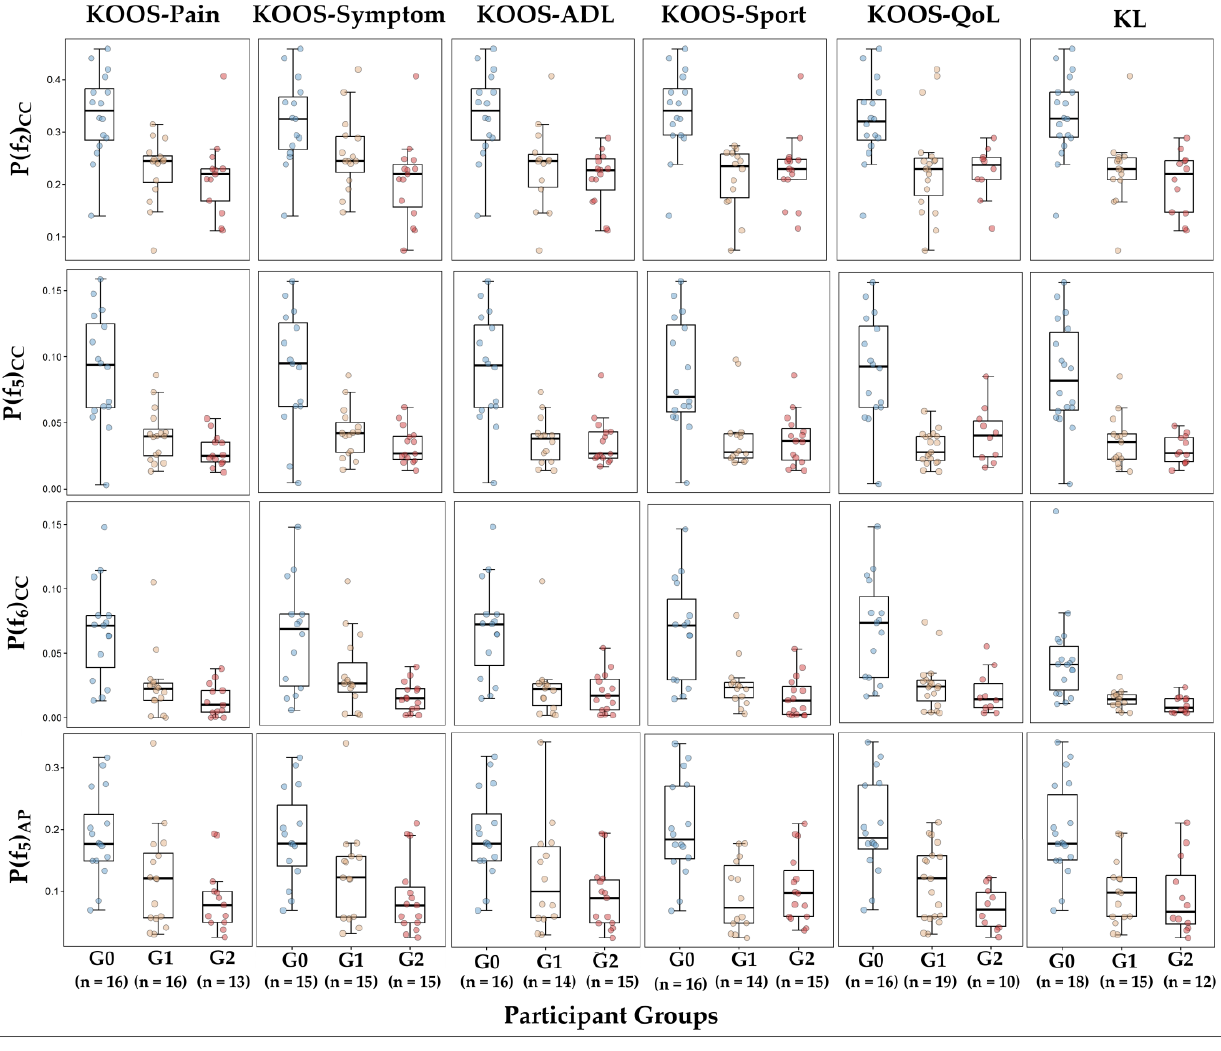
Figure 5. The distribution of the selected features in the final LASSO model between different groups of participants. G0: participants with mild or no knee OA, G1: participants with moderate knee OA, G2: participants with severe knee OA.